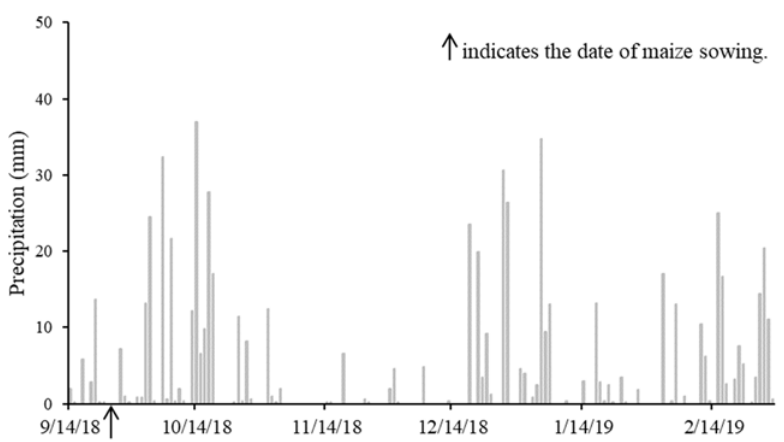
Figure 2. Daily rainfall data (mm) observed 10 days before maize sowing and during crop development. Ponta Grossa—PR.